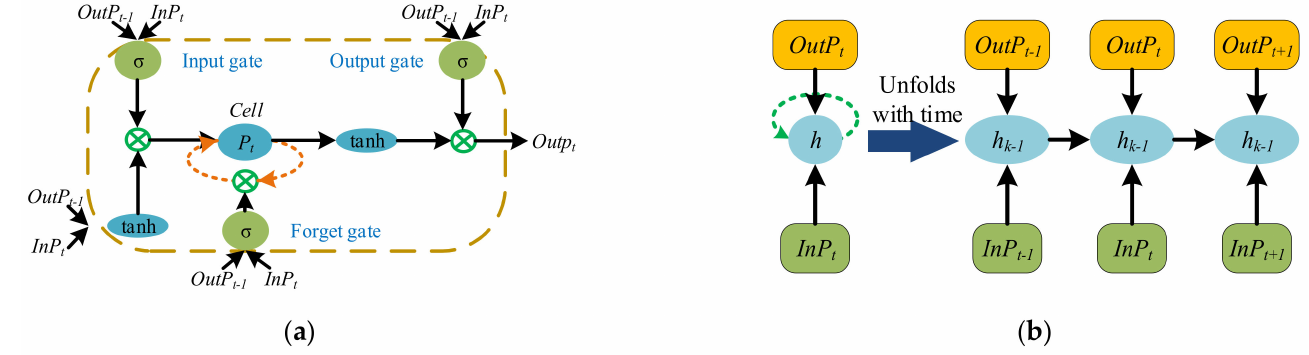
Figure 8. The schematic and framework of the LSTM-based state prediction network. ( a ) LSTM prediction schematic network. ( b ) The unfolded LSTM-RNN